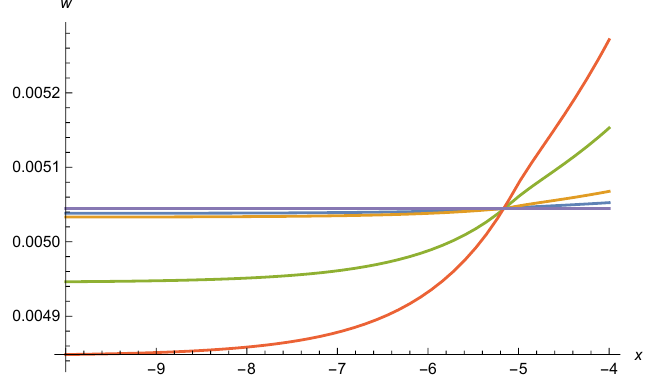
Figure 19. Dimensionless squared Planck mass w as function of x = ln ˜ ρ for ξ ∞ = 2 · 10 − 5 (blue), 10 − 4 (orange), 10 − 3 (green), and 0.003 (red), from top to bottom on the left. The horizontal line denotes the scaling solution which is approached for ξ ∞ → 0. All curves meet in a common point at x ≈ − 5.05.